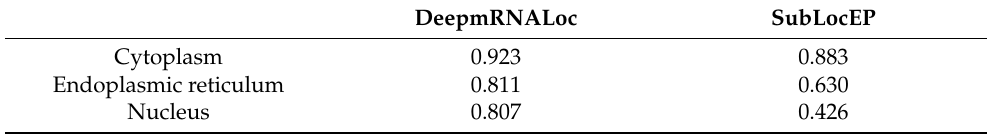
Table 4. Comparison of accuracy between DeepmRNALoc and SubLocEP based on Dataset 2.